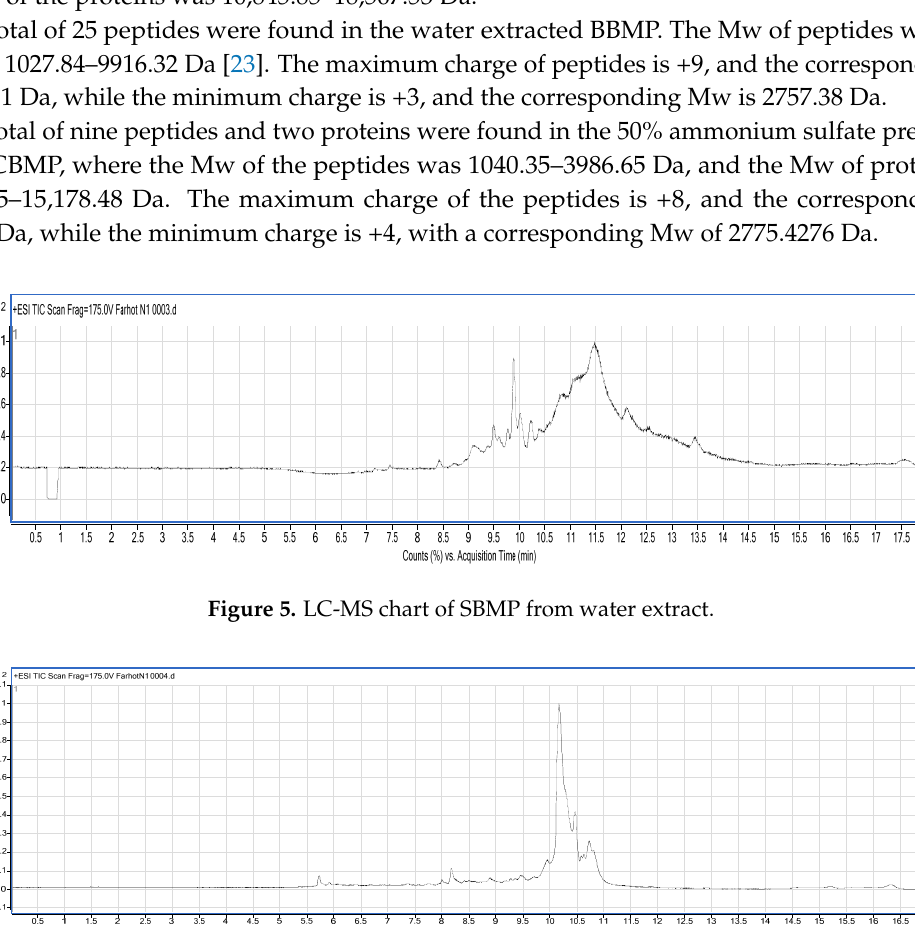
Figure 6. LC ‐ MS chart of BBMP from water extract.